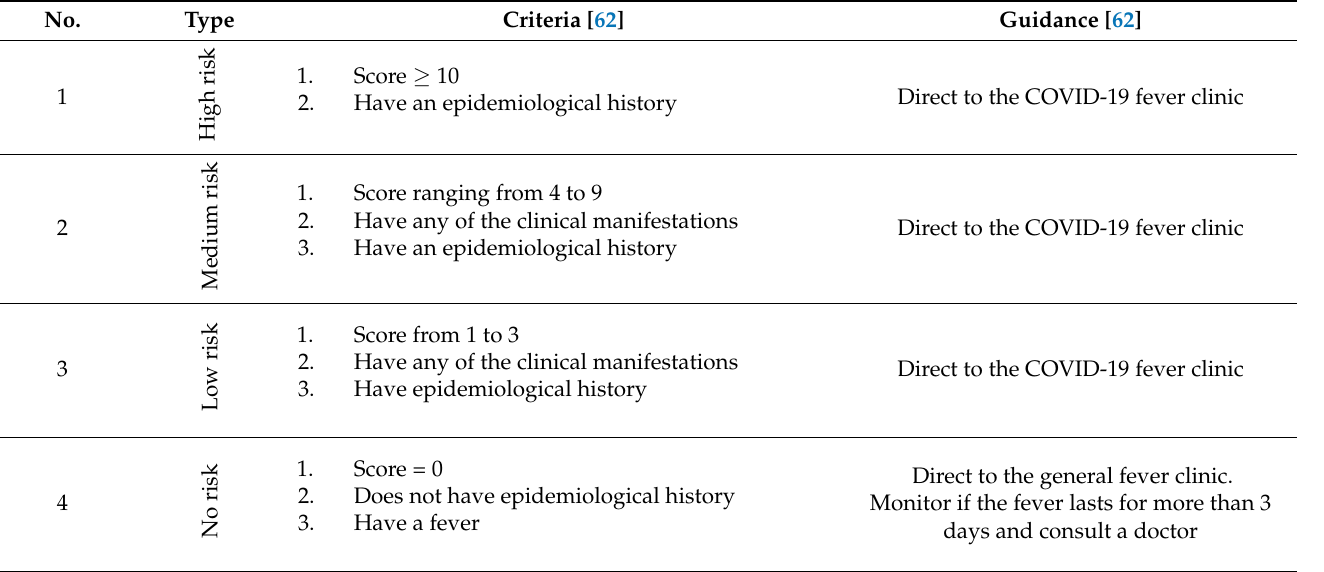
Table 7. Classification criteria of COVID-19 patients in approach